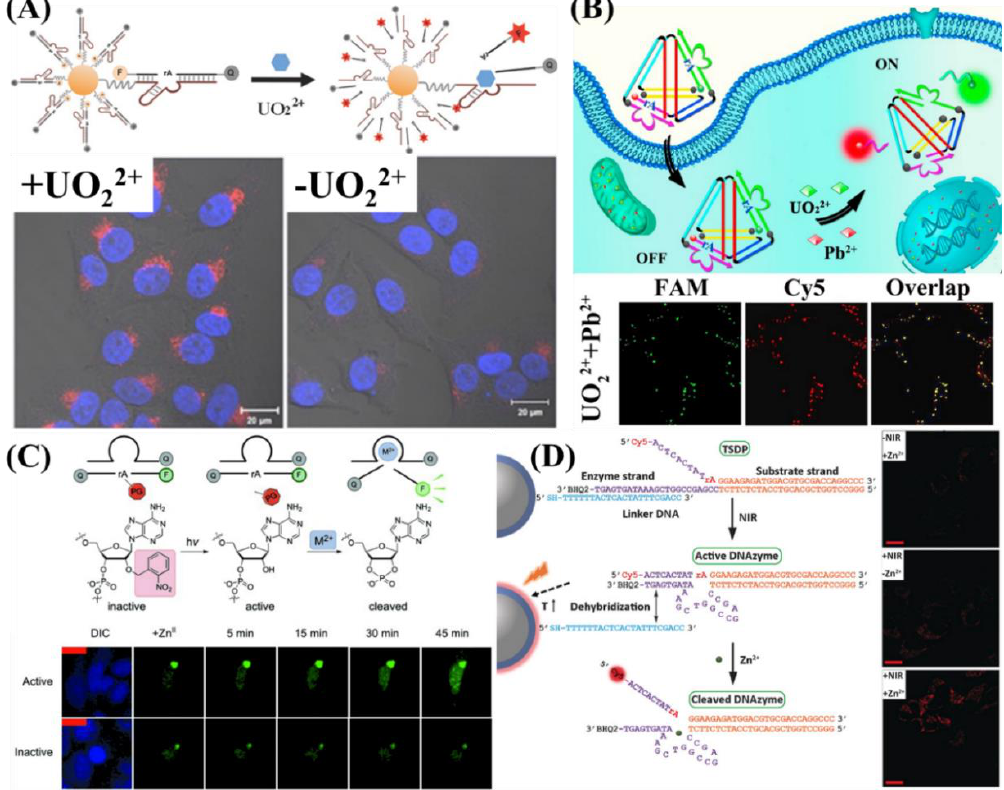
Figure 4. Representative examples of intracellular sensing and imaging of metal ions based on RNA-cleaving DNAzymes. ( A ) Design of a DNAzyme-gold nanoparticle probe for imaging UO 22+ in living cells. Reprinted with permission from reference [34]. Copyright 2013 American Chemical Society. ( B ) Multiplexed detection of intracellular UO 22+ and Pb 2+ with the DNAzyme tetrahedron nanoprobes. FAM = fluorescein, Cy5 = Cyanine-5. Reprinted with permission from reference [40]. Copyright 2016 Elsevier. ( C ) Design of the caged DNAzyme-based catalytic beacon probe for intracellular imaging of Zn 2+ . F, Fluorophore; Q, Quencher; PG, protecting group (o‐nitrobenzyl). Scale bar: 20 μm. Reprinted with permission from reference [43]. Copyright 2014 Wiley-VCH. ( D ) Design of near-infrared, photothermal-activated DNAzymes – gold nanoshells for intracellular Zn 2+ sensing. Reprinted with permission from reference [44]. TSDP = three-stranded DNAzyme precursor. Copyright 2017 Wiley-